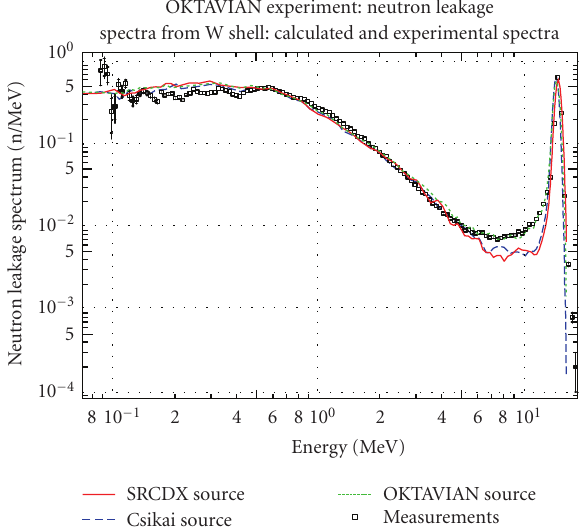
Figure 10: Neutron leakage spectra obtained with di ff erent source models implemented, benchmarked with the experimental mea- surements of OKTAVIAN W sphere